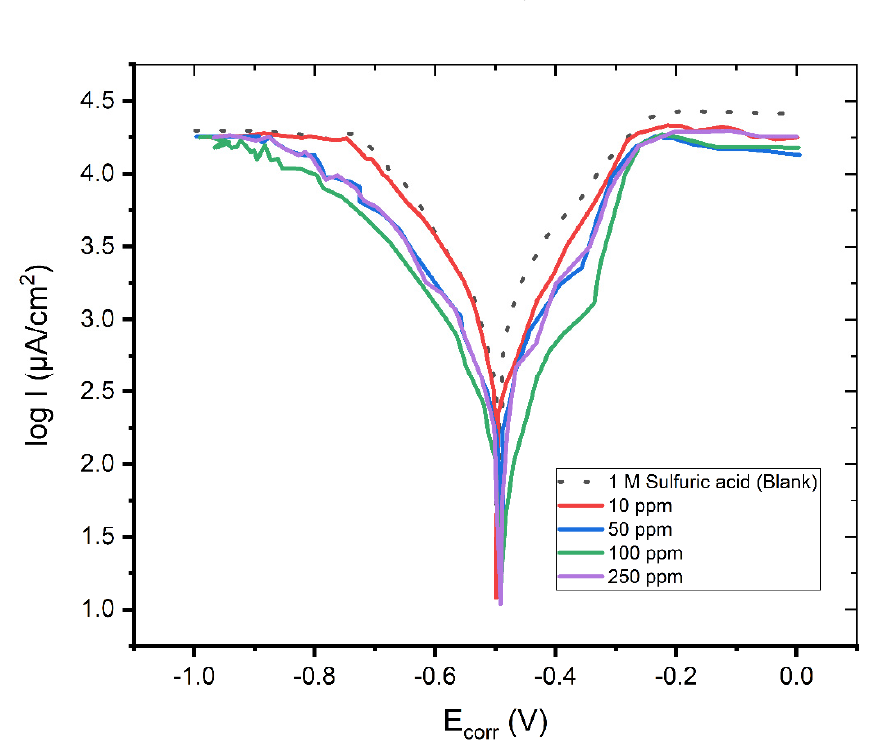
Figure 1. The Tafel plot of the mild steel electrode measured in a H 2 SO 4 solution (c = 1 M) in the absence and in the presence of 10, 50, 100, and 250 ppm of Pantoprazole.